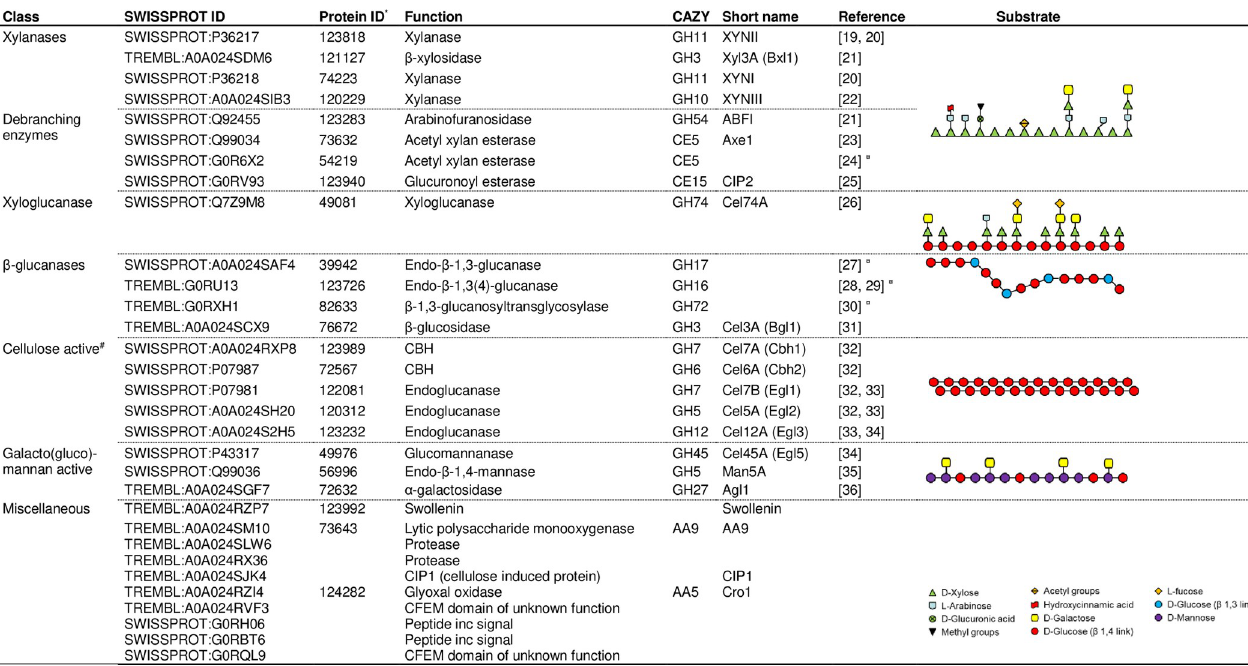
Fig 1. Proteins identified in MultiGrain grouped by enzyme class and substrate. References to characterization of the identical T . reesei enzyme are reported if available, otherwise reference to close fungal homologs are added to the table [19–36].Structure diagrams are included to illustrate simplified polysaccharides commonly found in the discussed plant materials. � ID according to T . reesei database v2.0 [17], # Including endoglucanase, cellobiohydrolase, and betaglucosidase, ¤ Homolog characterized enzyme from different source.